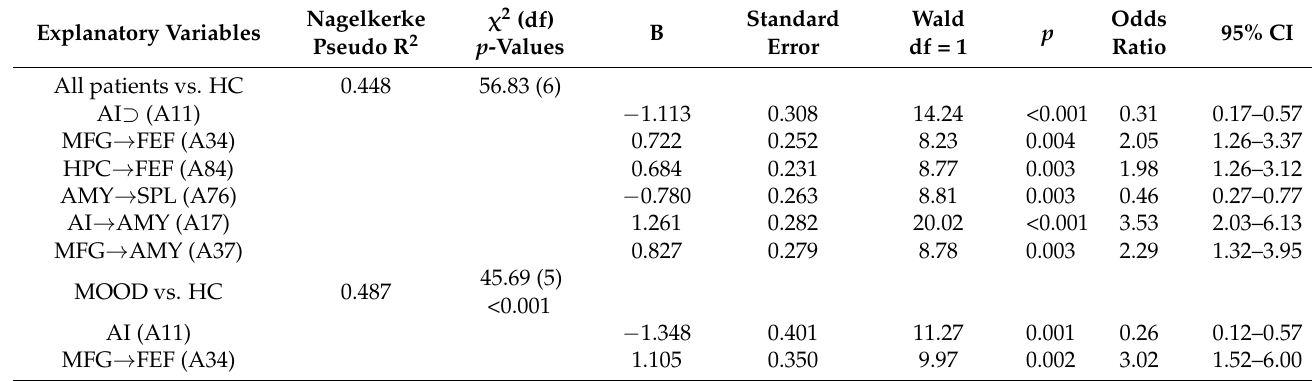
Table 2. Results of linear logistic regression analysis with the psychiatric patients’ groups (SCZ, BD and MDD) as dependent variable, and controls as reference group.